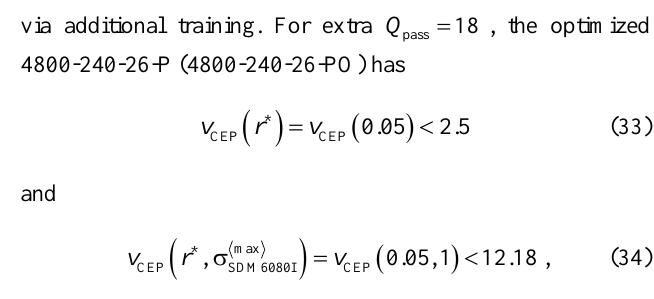
v r on 25 trained 4800-240-26-P by parameters (27). CEP